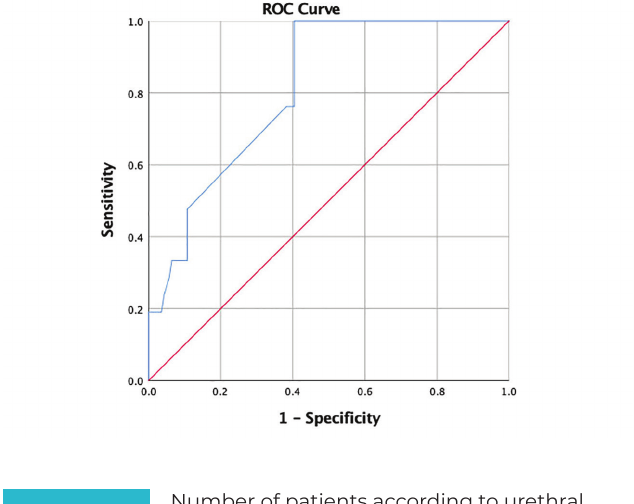
Number of patients according to urethral Table 3 stricture localization